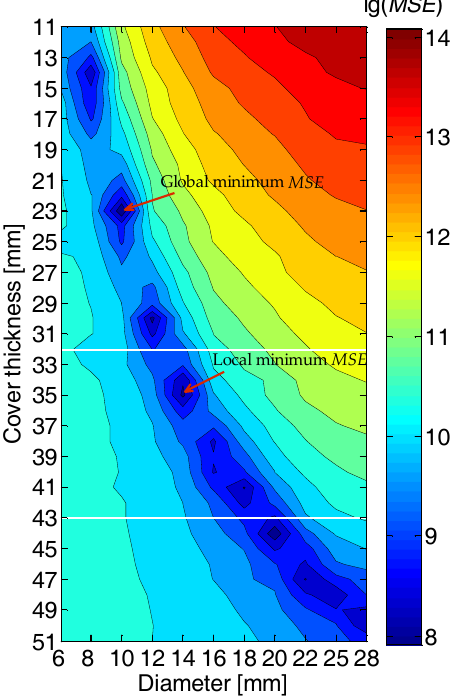
Figure 11. Contour plot presenting the MSE s calculated between the measured and calibrated EMI data for simultaneous estimation of the rebar diameter and cover thickness. The range of the GPR-estimated cover thickness is marked by two horizontal white lines. The global minimum MSE and local minimum MSE are respectively indicated by the red arrows.